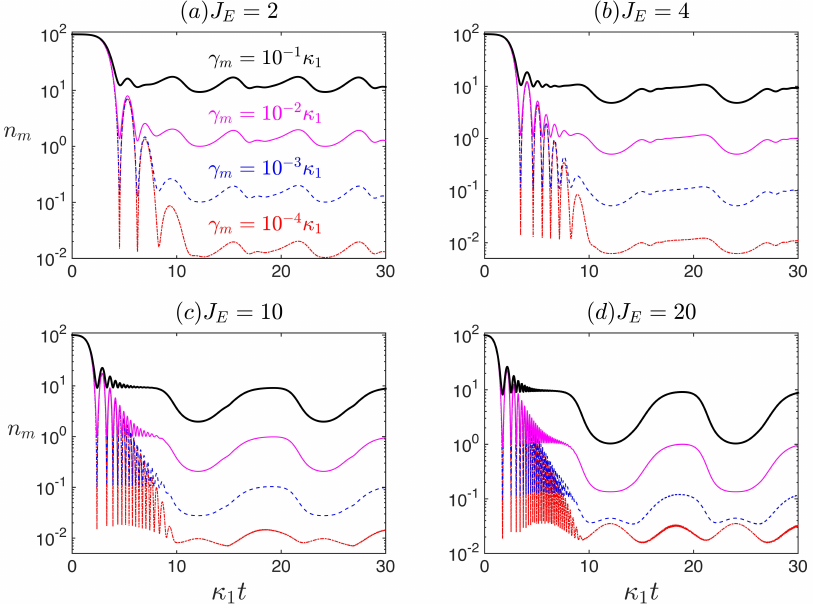
Figure 5. Dynamical evolution processes under two pulsed drives, which are simulated for various damping rates γ m while the effective coupling intensity is fixed (four different values of J E = 2,4,10, and 20 are considered, respectively). Here, γ m / κ 1 = 10 − 1 (black), 10 − 2 (pink), 10 − 3 (blue), and 10 − 4 (red), respectively. The fixed parameters are the same as those in Figure